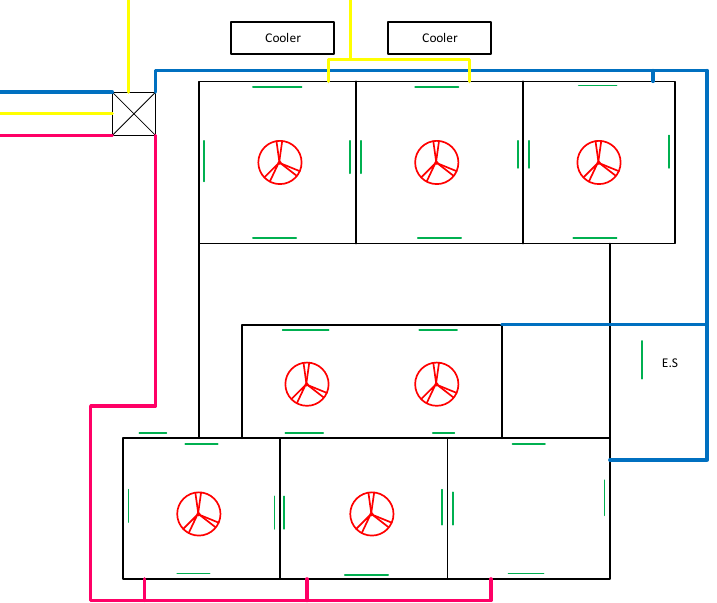
Figure 20. Proposed model for the Staff